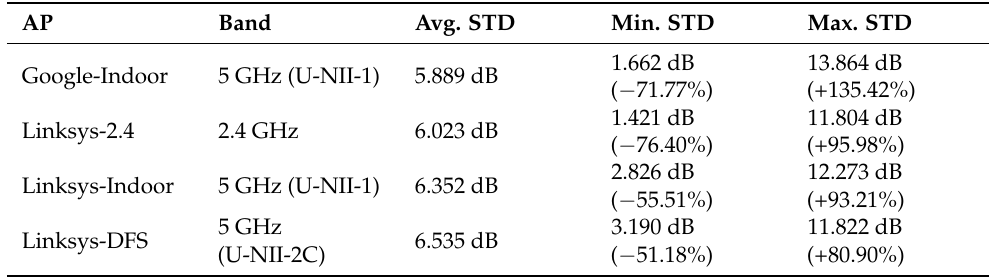
Table 5. Stability of the RSS observations (minimum, maximum, and average standard deviation) for each AP vendor and frequency channel.